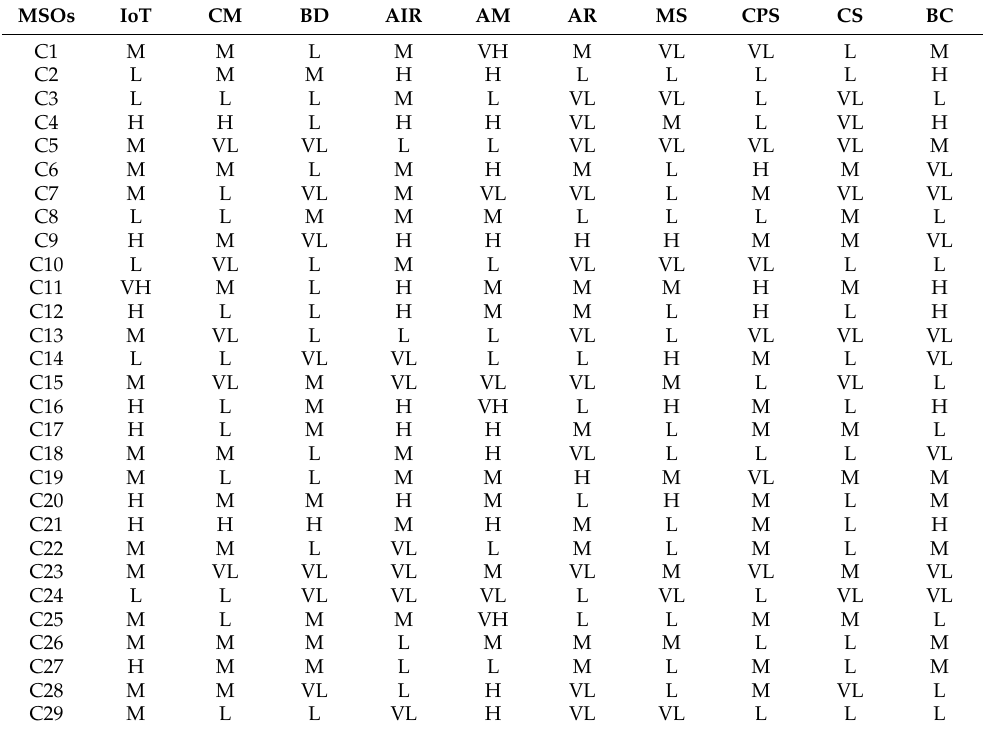
Table 7. An example of the collected data from one of the experts for the alternatives evaluation.